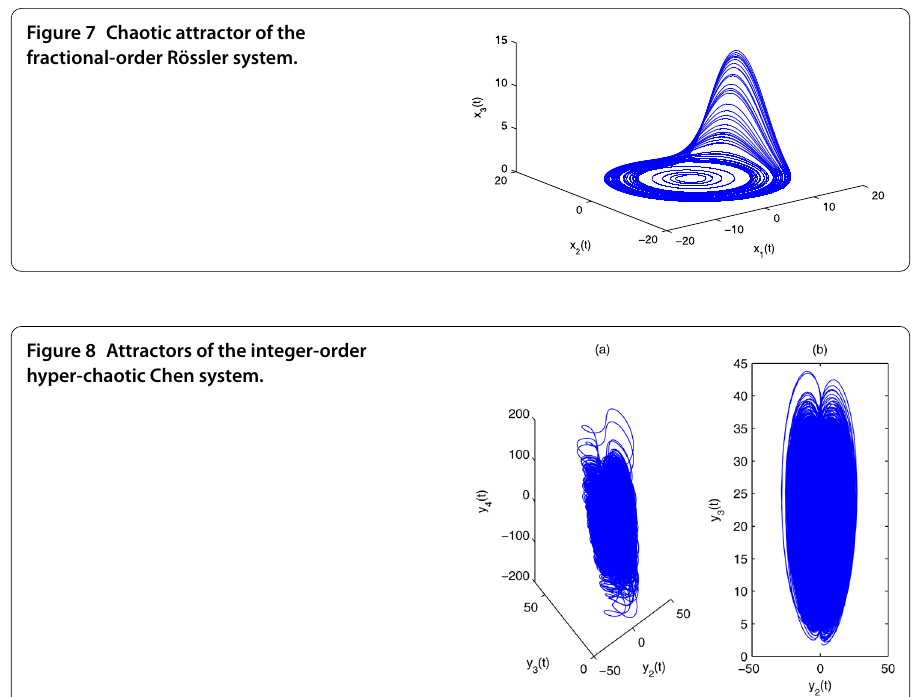
Figure 7 Chaotic attractor of the fractional-order Rössler system.